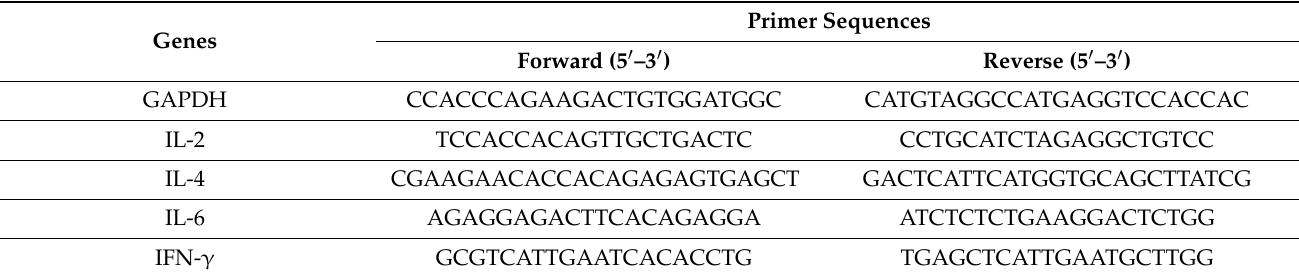
Table 5. Primers for real-time quantitative